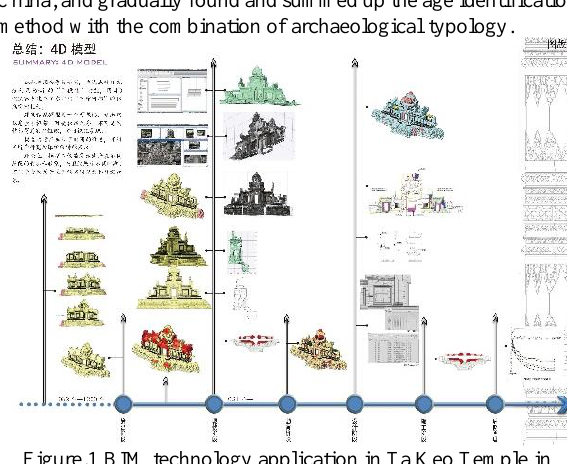
Figure.1 BIM technology application in Ta Keo Temple